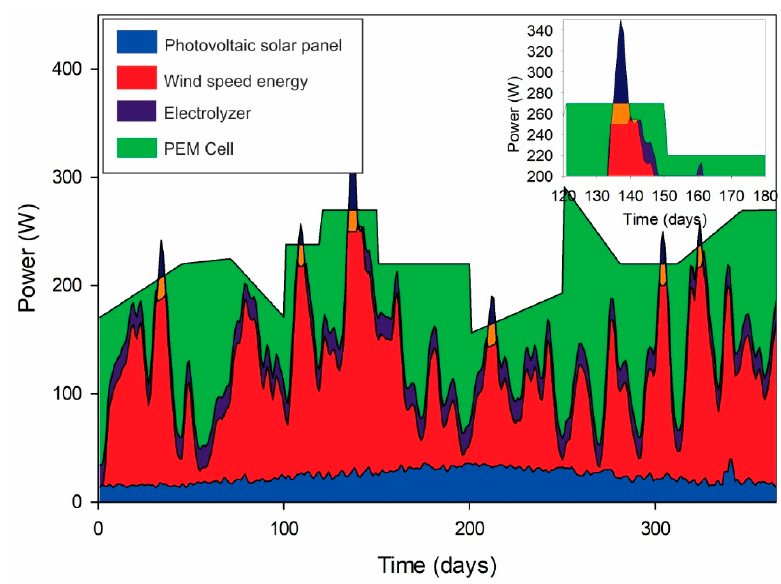
Figure A2. Power for Beijing.